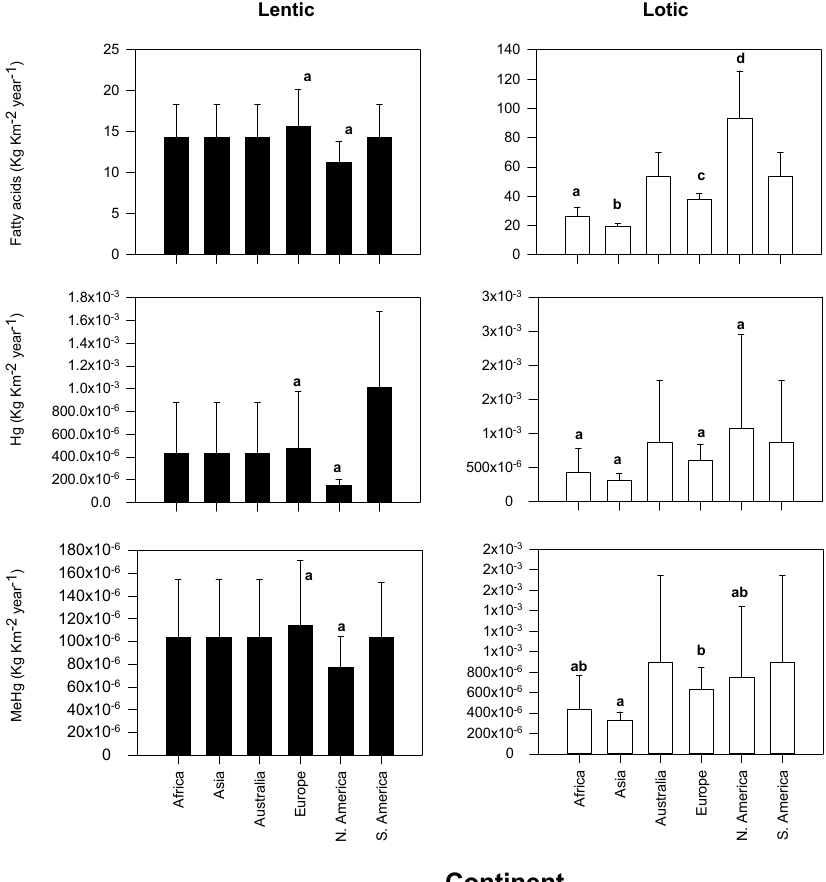
Figure 2. Estimate (± SD) of physiologically important fatty acids, methylmercury (MeHg) and total mercury (Hg) calculated for each continent. The letters depict results from Medcalc ® comparison of means calculator within each continent, where values with the same letters depict no significant difference between the export values. Note that only continents where emergence data are available are statistically compared.